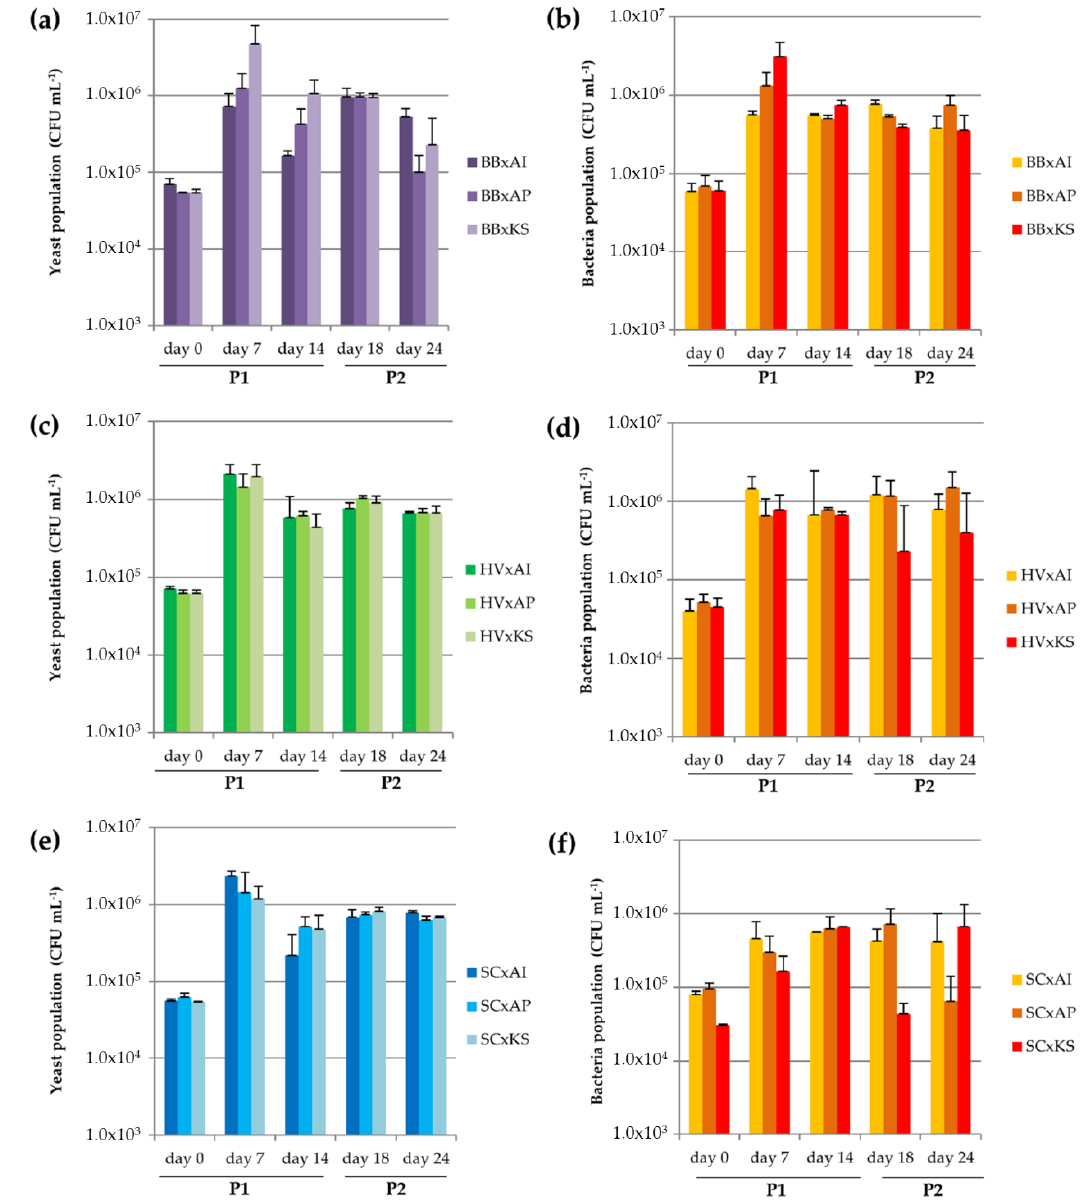
Figure 2. Microbial populations of yeast and bacterial cocultures in sugared black tea determined by plate counting (CFU mL − 1 ). Error bars correspond to the confidence interval with α = 0.05 ( n = 3). ( a ) and ( b ) Yeast and bacterial populations, respectively, in cocultures involving Brettanomyces bruxellensis (BB). ( c ) and ( d ) Yeast and bacterial populations, respectively, in cocultures involving Hanseniaspora valbyensis (HV). ( e ) and ( f ) Yeast and bacterial populations, respectively, in cocultures involving Saccharomyces cerevisiae (SC). AI = Acetobacter indonesiensis , AP = Acetobacter papayae , and KS = Komagataeibacter saccharivorans .